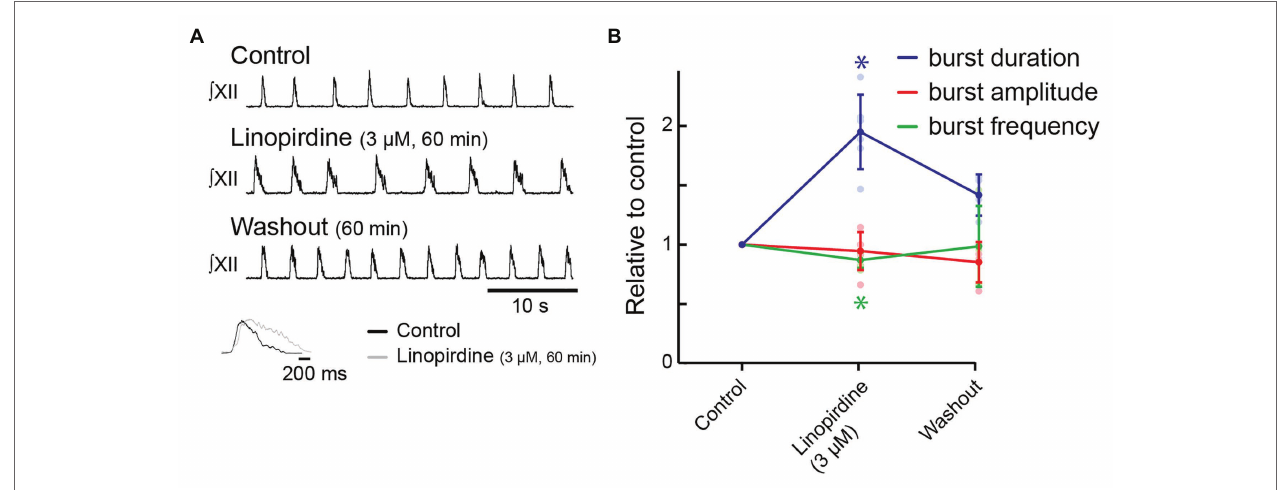
FIGURE 4 | Effects of blocking KCNQ channels with linopirdine on inspiratory burst parameters in the rhythmic slice preparation. (A) Rectified, integrated recordings from XII nerve rootlets demonstrating inspiratory burst parameter changes in the presence of bath application of linopirdine. Inset shows an average of 10 inspiratory bursts in control (black) and after 60 min of bath application of linopirdine (light gray). (B) Group data from XII nerve rootlet recordings where linopirdine was applied to the bath at 3 μ M, n = 6, n = 4 washout. * p < 0.05, mixed-effects model with Tukey’s multiple comparisons post hoc